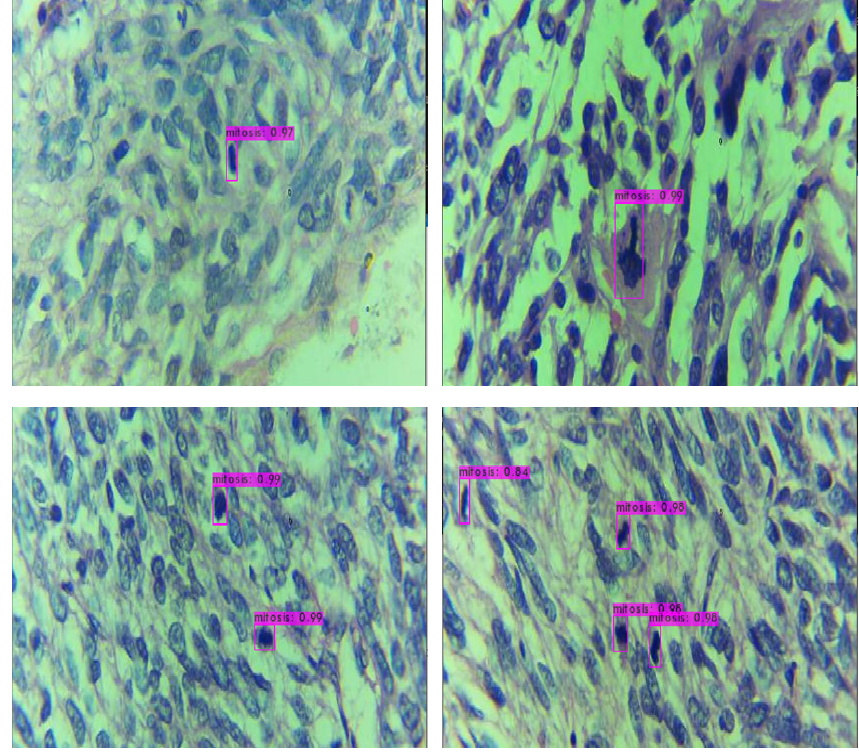
Figure 6. Example of the detection mitosis objects in input images. The purple box around the detected mitosis region along with the confidence score. Table 3. Comparison of the baseline method (YOLOv4) with the SSD model and Faster R-CNN model on the test dataset of the proposed